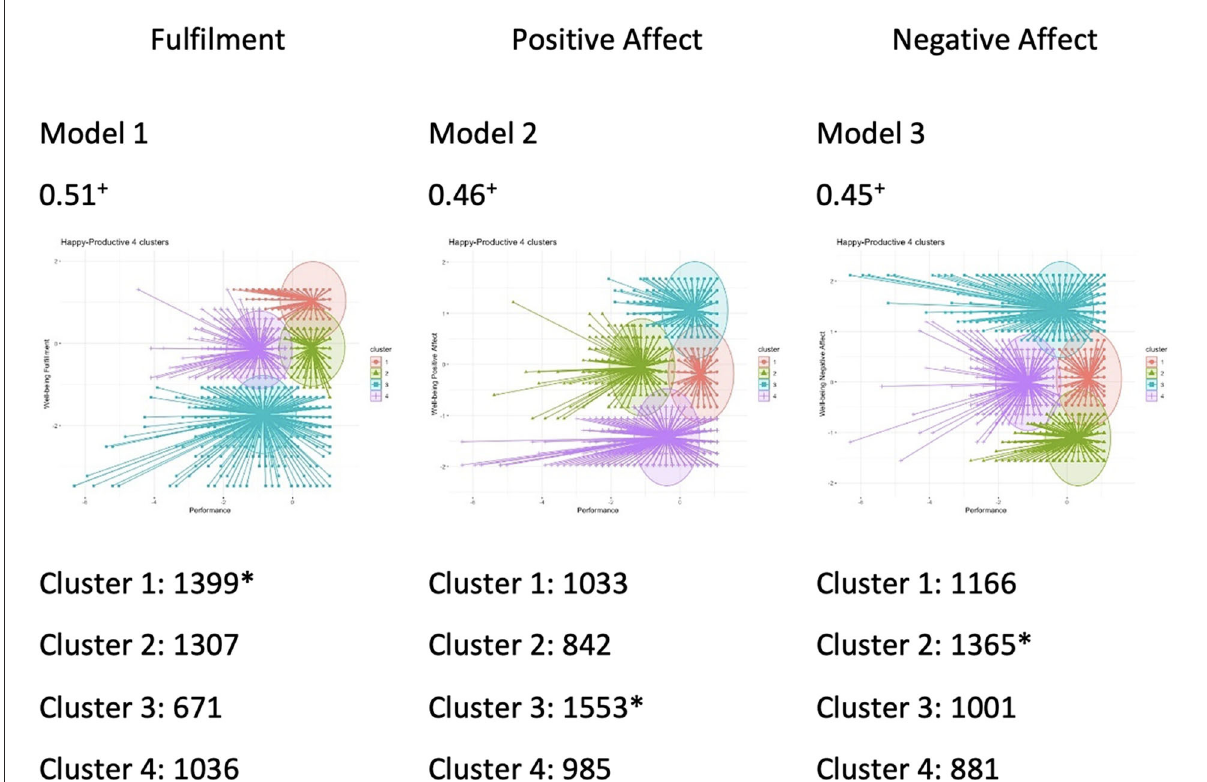
FIGURE2 Size and fit of clusters between wellbeing and performance. Performance is on the X -axis and Wellbeing is on the Y -axis; + value of the silhouette contour. *Indicates the reference quadrant, the